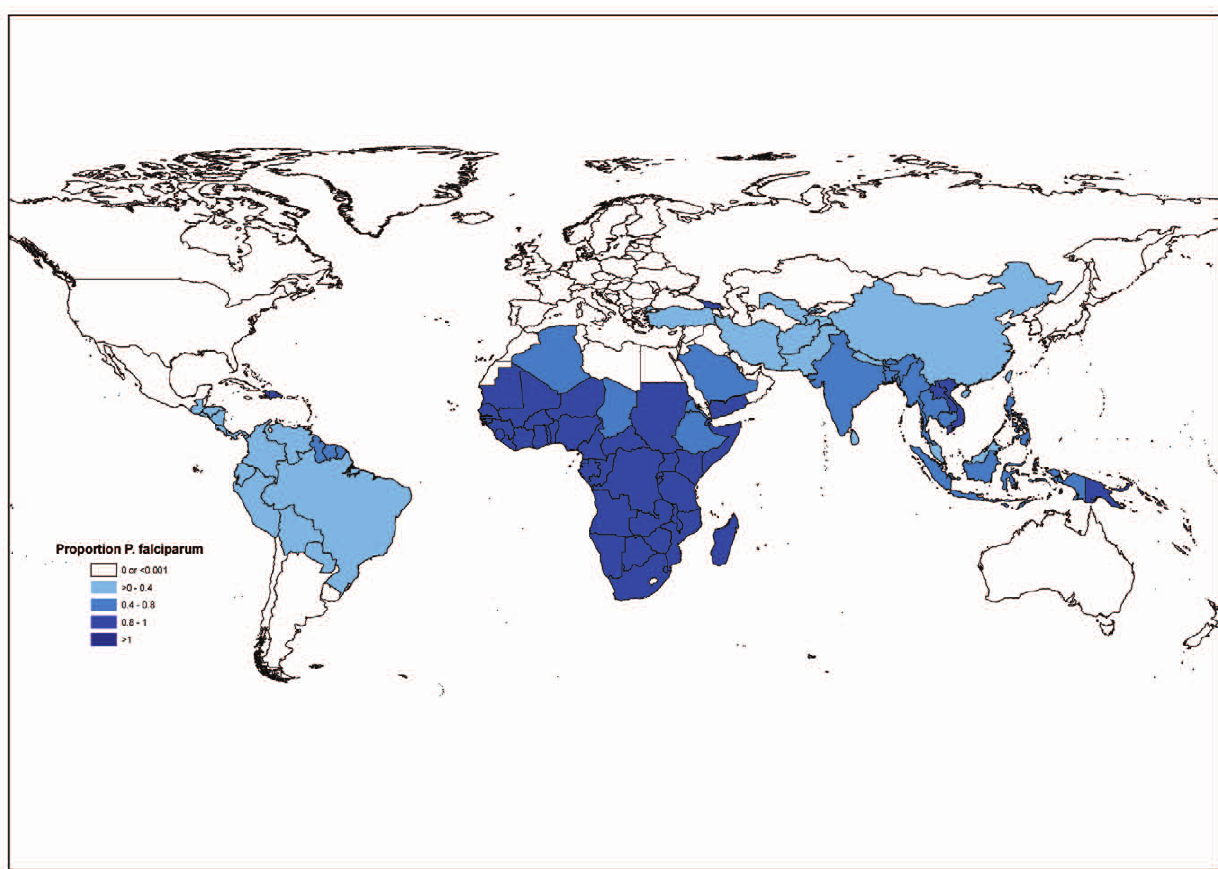
Figure 3. The percentage of reported malaria cases due to P.falciparum in 99 endemic countries.